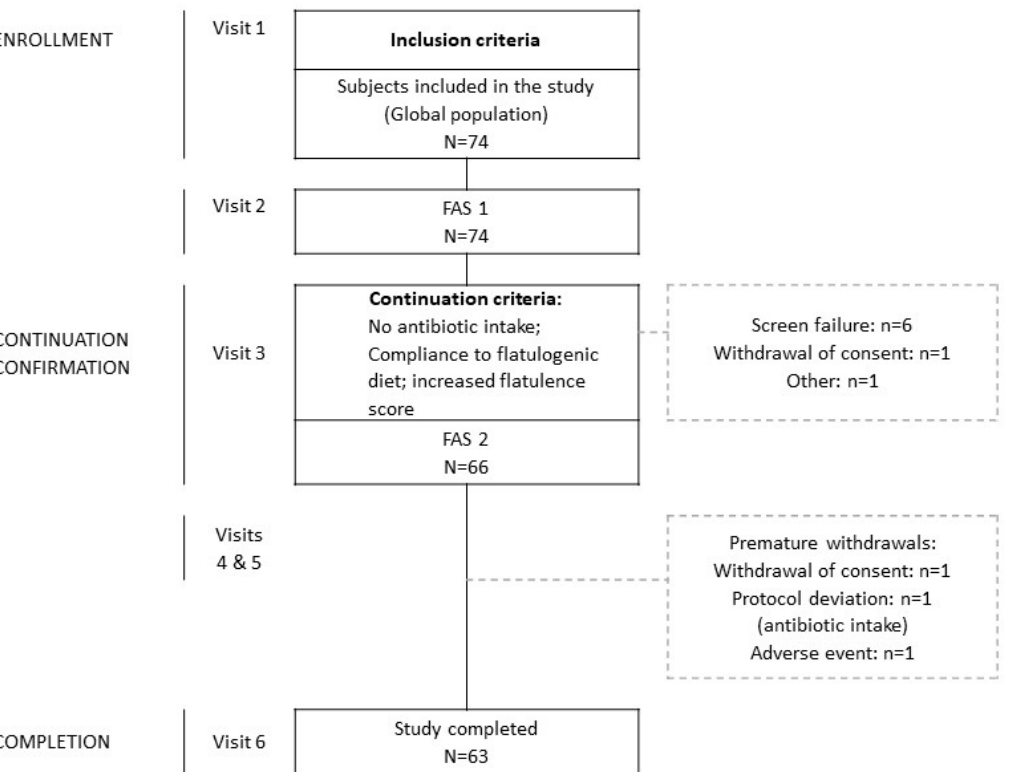
Figure 2. Flow-chart. FAS 1: Full Analysis Set 1; FAS 2: Full Analysis Set 2. Adverse event corresponds to urinary infection.